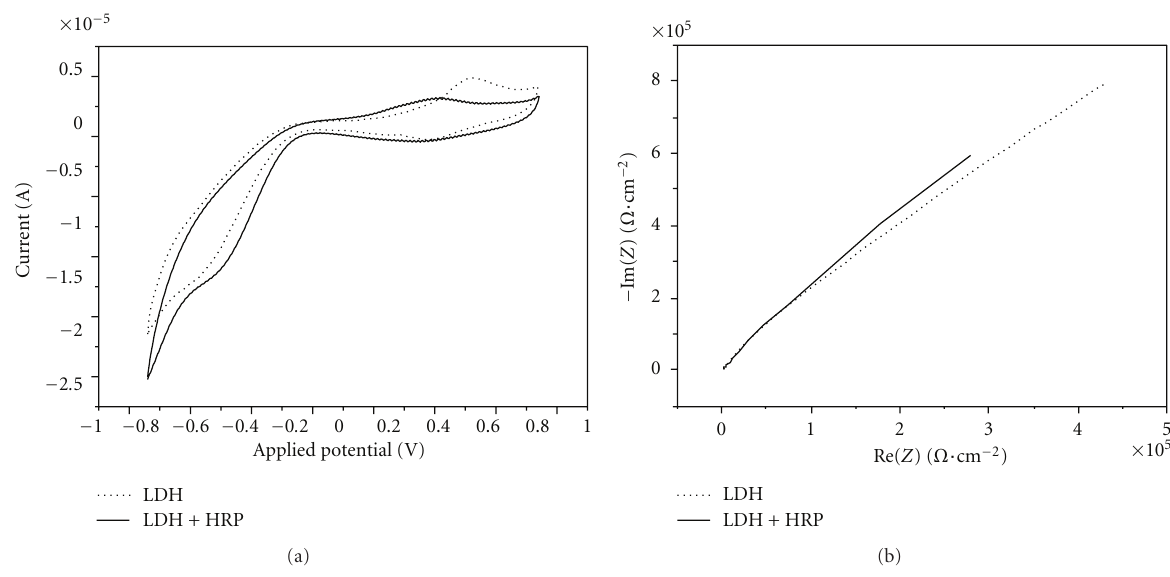
Figure 2: (a) Cyclic voltammogram of gold electrode functionalized with LDH before and after HRP immobilization. (b) Nyquist diagram ( Z i versus Z r ) of impedance measurement corresponding to the gold-electrode with LDH before and after HRP